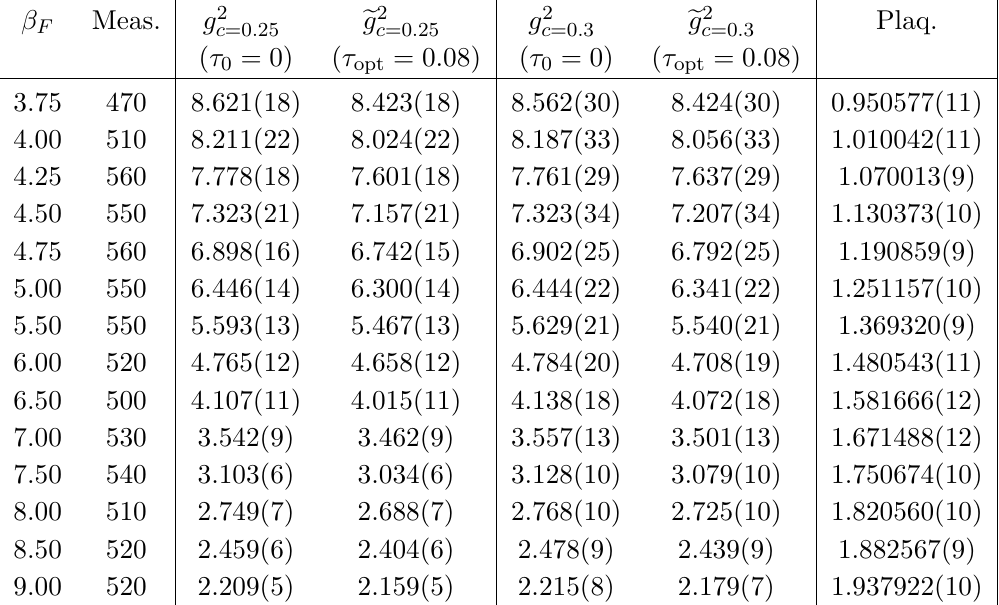
Table 8 . 30 4 lattice ensembles used in this work, with columns as in table